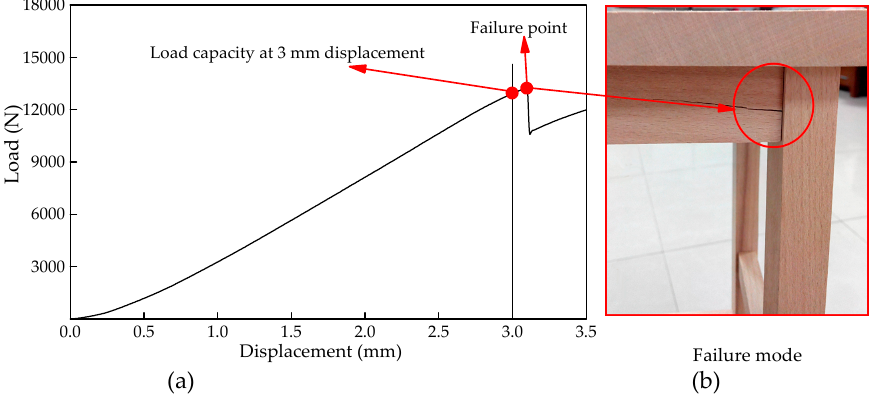
Figure 10. Typical load and displacement curve ( a ) and failure mode ( b ) of chair under compression.